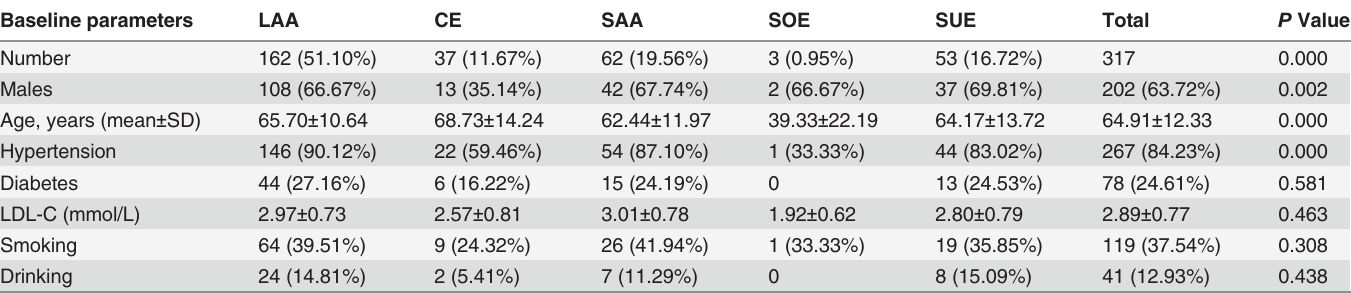
Table 1. Baseline data of various stroke subtypes.